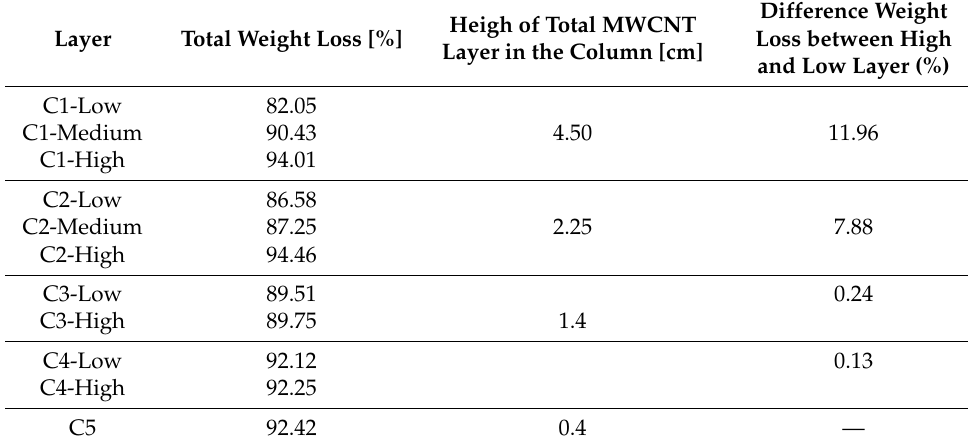
Table 6. Relative weight losses of TG curves.